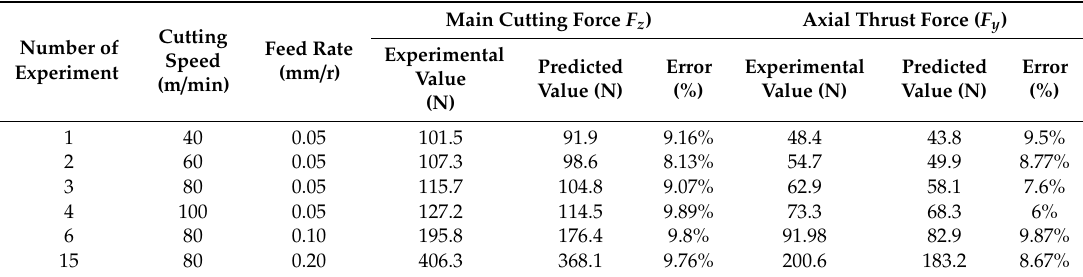
Table 10. Cutting force simulation and experimental value Error % prediction